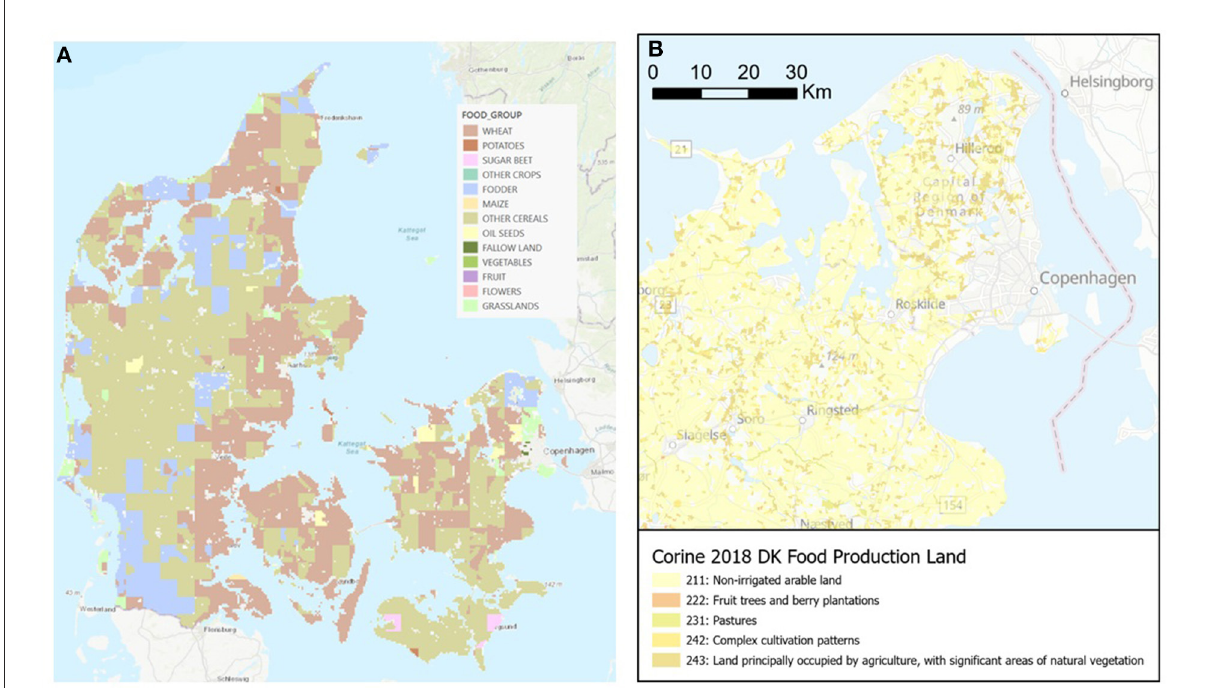
FIGURE4 Map of Danish food group production for 2019 as extracted from FSU data, at a 1-km resolution (A) and agricultural zones around Copenhagen as extracted from CORINE (B) .